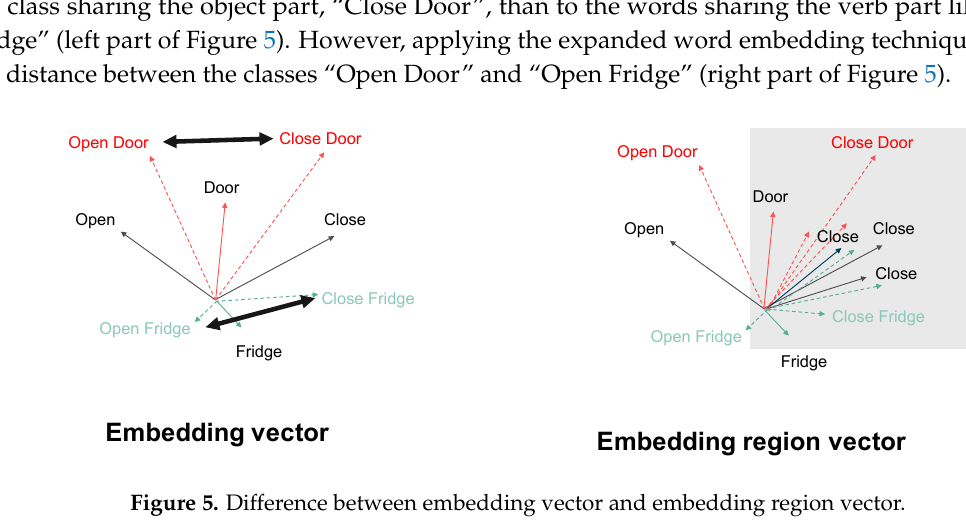
Figure 5. Difference between embedding vector and embedding region